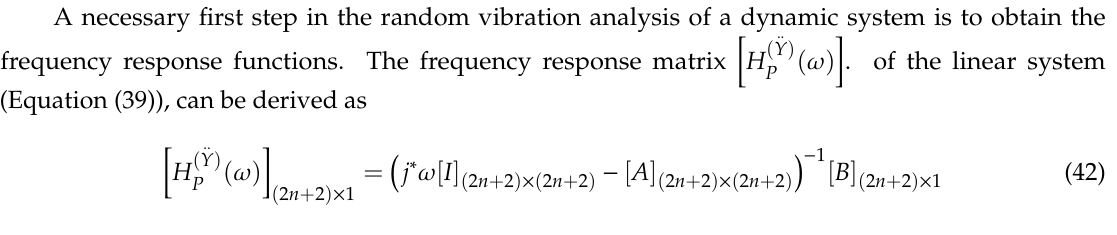
Figure 7. Frequency response curves of (cid:1874) (cid:2869) and (cid:1874) (cid:2870) due to harmonic base acceleration.